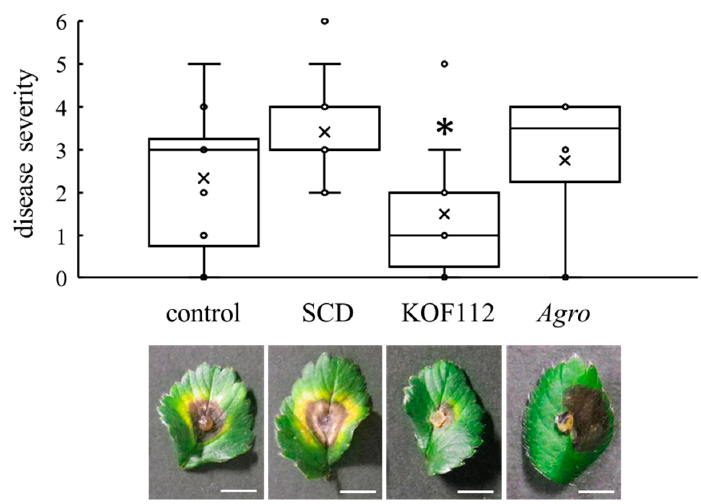
Figure 7. Suppression of strawberry anthracnose by KOF112. Disease severity was evaluated as described in Materials and Methods. Crosses (×) indicate means of four independent experiments with three leaves. * p < 0.05 compared with control and SCD. Each representative symptom of strawberry anthracnose on detached leaves is shown below the graph. Control, untreated. SCD, treated with 10% SCD. KOF112, treated with 1 × 10 8 cfu/mL KOF112. Agro , treated with 1 × 10 8 cfu/mL Agrobacterium sp. isolate CHB3, used as a control isolate with no antifungal activity. Bar, 1 cm.